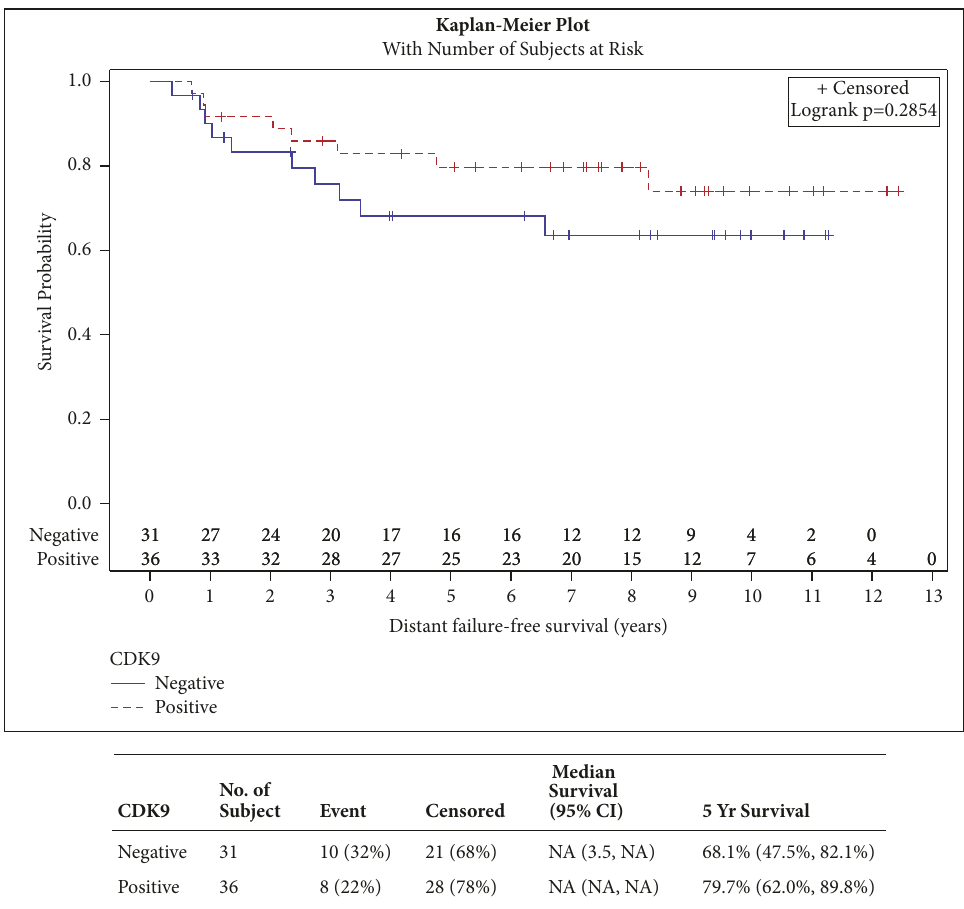
Figure 2: Distant failure-free survival . Figure 2 shows distant failure-free survival curves for patients with CDK9 positive versus CDK9 negative tumors. This shows a statistically nonsignificant difference in the two survival curves. However, there is a trend for increased distant failure free survival in the group of patients with positive CDK9.